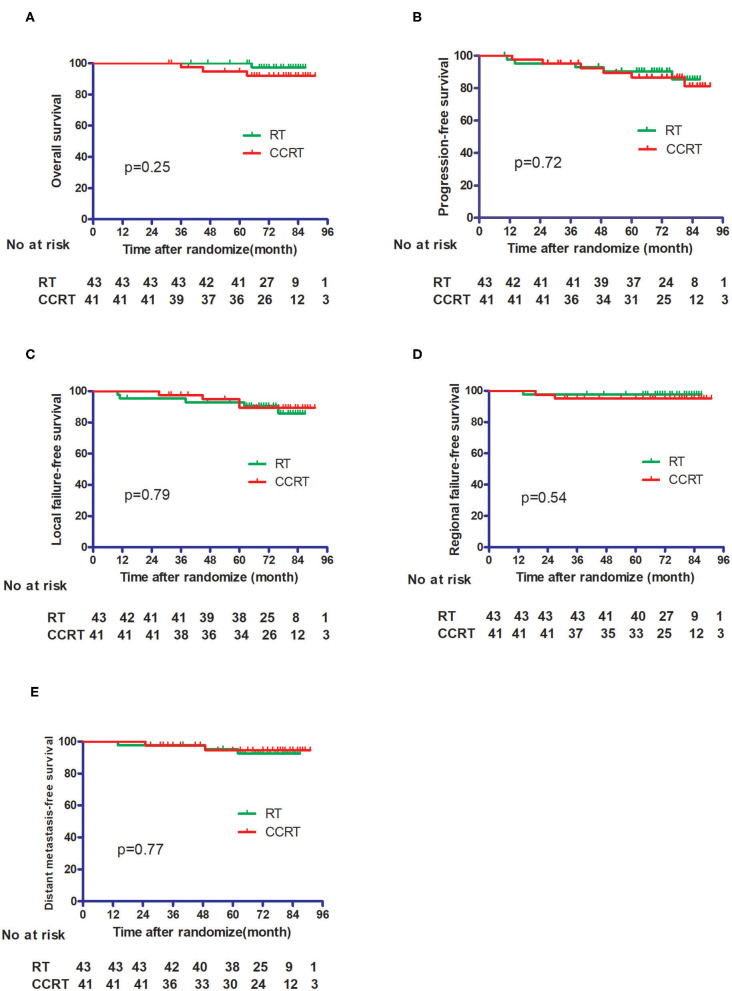
Comparison of the treatment results between the IMRT alone group and the CCRT group. (A) Overall survival. (B) Progression-free survival. (C) Local failure-free survival. (D) Regional failure-free survival. (E) Distant metastasis-free survival.